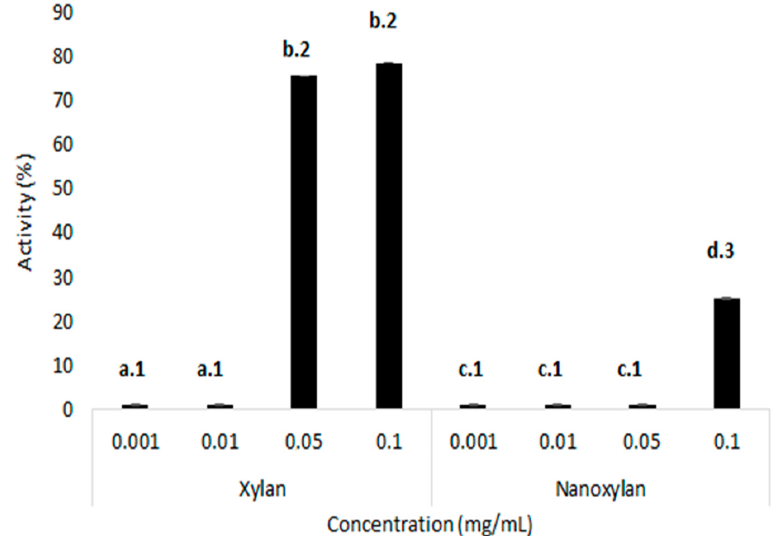
Figure 9. Iron-chelating activity of xylan and nanoxylan. Different letters (a, b, c, and d) represent statistically significant differences between the same concentration of xylan and nanoxylan. Different numbers (1, 2, and 3) represent statistically significant differences between different concentrations (0.001; 0.01; 0.5; 0.1 mg/mL) of xylan and nanoxylan (0.001; 0.01; 0.05; 0.1 mg/mL). p < 0.01.